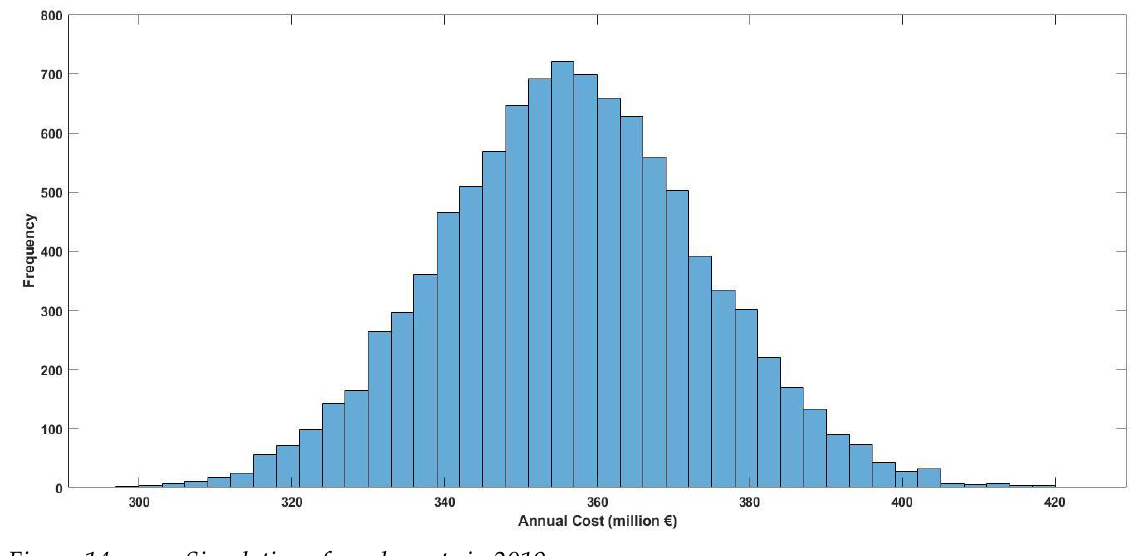
Figure 14. Simulation of yearly costs in 2019